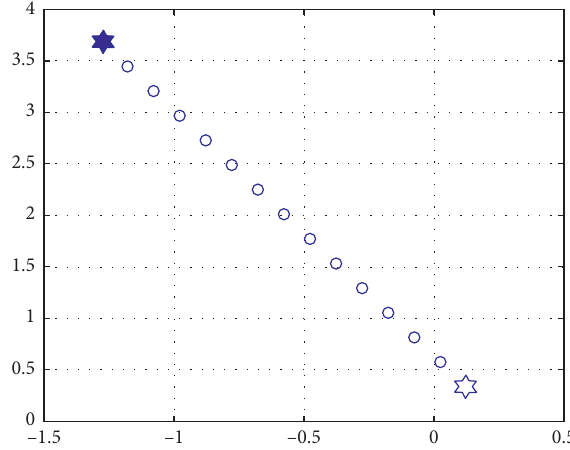
6: Trajectory of the formation center for the leaderless